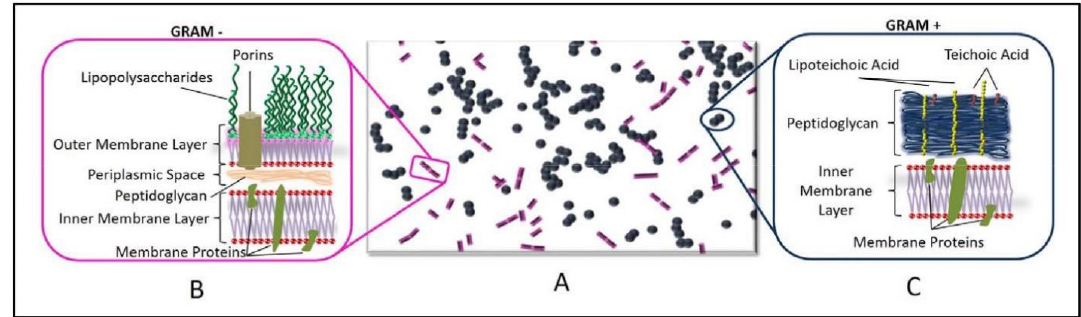
Figure 7. ( A ) scheme of a Gram staining experiment with a mix of crystal violet stained cocci (Gram-positive bacteria) (blue) and safranin stained bacilli (Gram-negative) (purple) bacteria on a slide and comparison of the cell wall in Gram-negative ( B ) and -positive ( C ) bacteria.